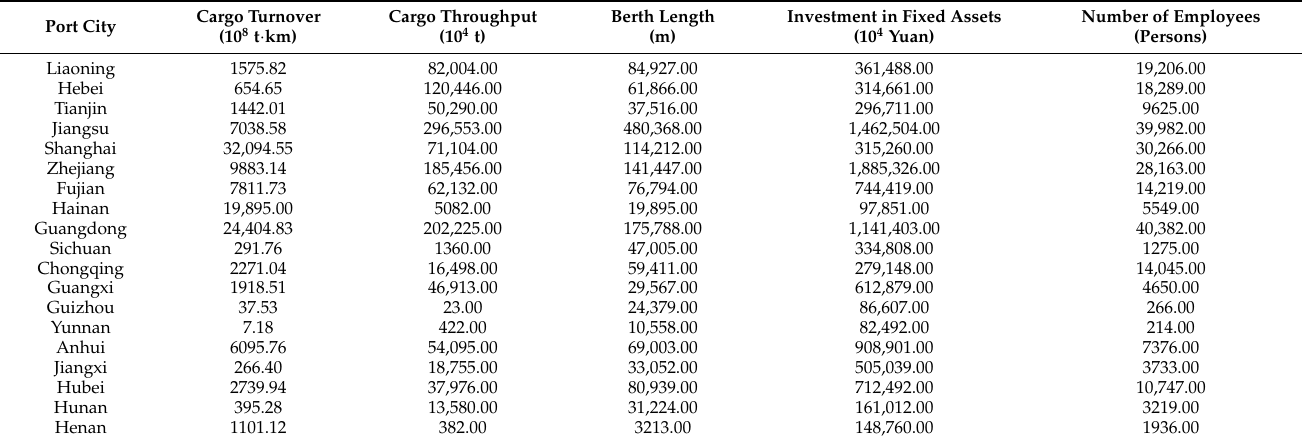
Table A1. The inputs and outputs (take 2020 as an example).